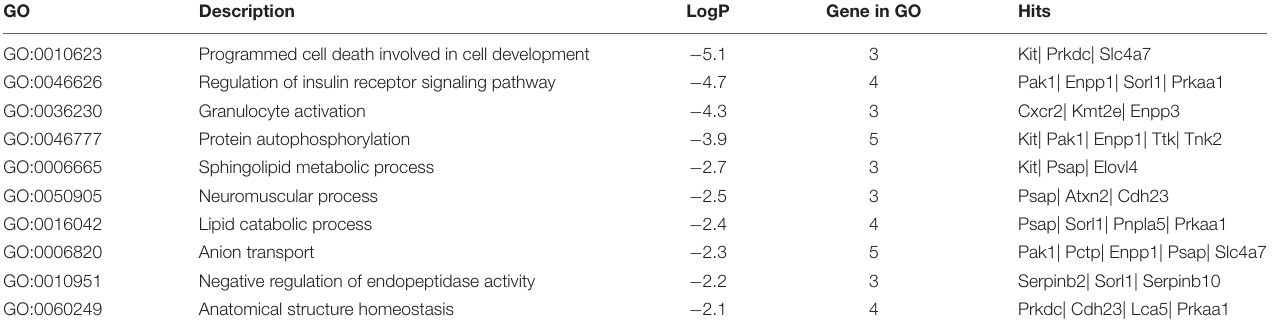
TABLE 3 | Top non-redundant enriched GO terms of candidate genes.